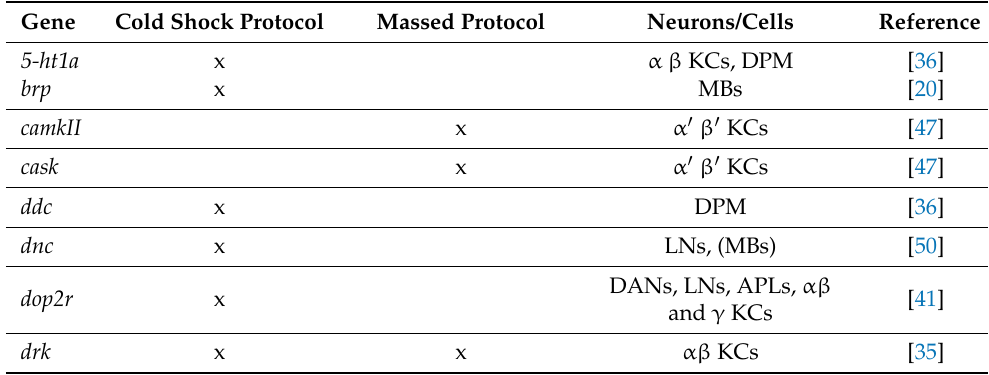
Table 3. Genes involved in ARM have been tested in either or both protocols that yield ARM, and their role has been identified in specific neuronal